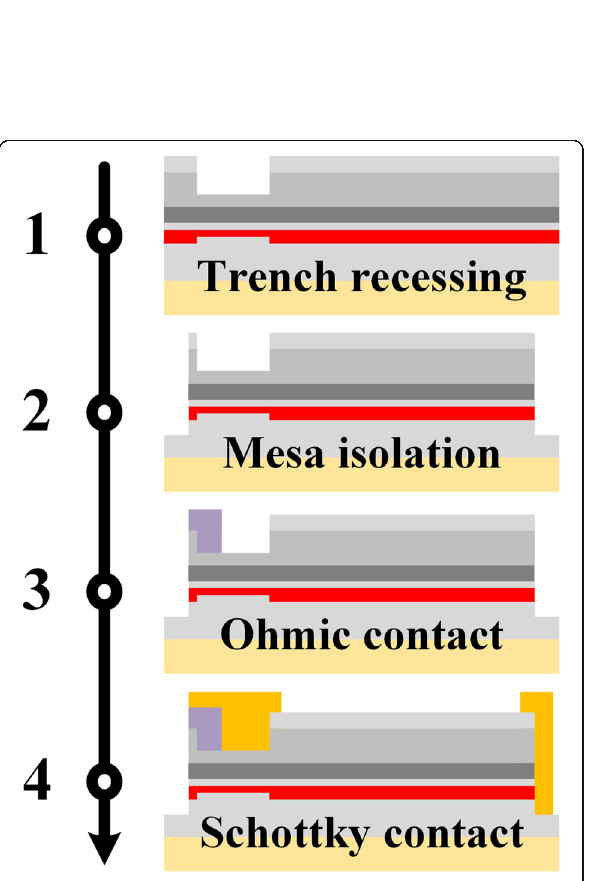
Fig. 2 Manufacturing process flow of the RB-CRD